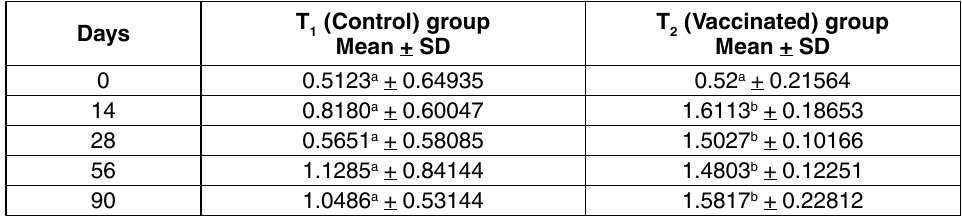
table 1. Statistical analysis of ELISA titre in control and vaccinated birds